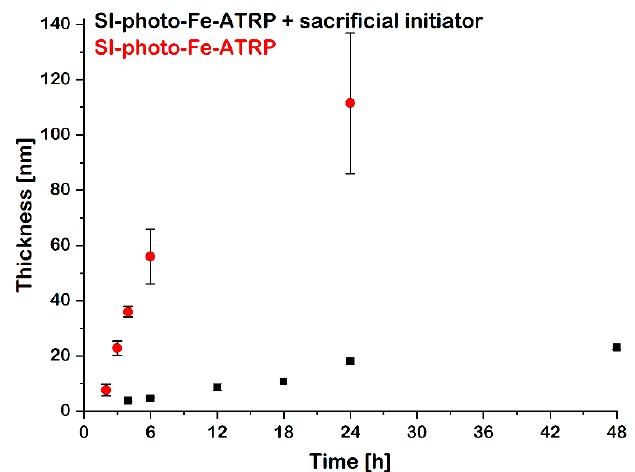
Figure 7. Brush thickness evolution with time of SI-photo-Fe-ATRP in the presence (black color) and without (red color) sacrificial initiator.